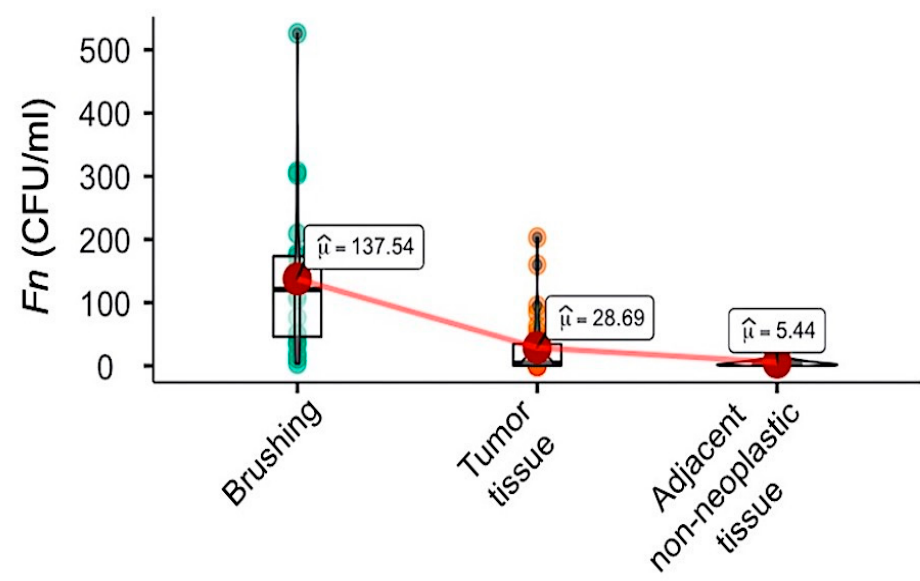
Figure 1. Fusobacterium nucleatum ( Fn ) abundances in matched oral/colonic tissues from colon cancer patients by qPCR. The figure shows the violin plots of Fn in the two body districts, oral cavity and colon tissues (tumor tissue and adjacent non-neoplastic colon mucosa) of the cases examined. Big dots represent 10% trimmed mean ( µ ), and related box plots represent median and interquartile range. CFU: colony-forming units.